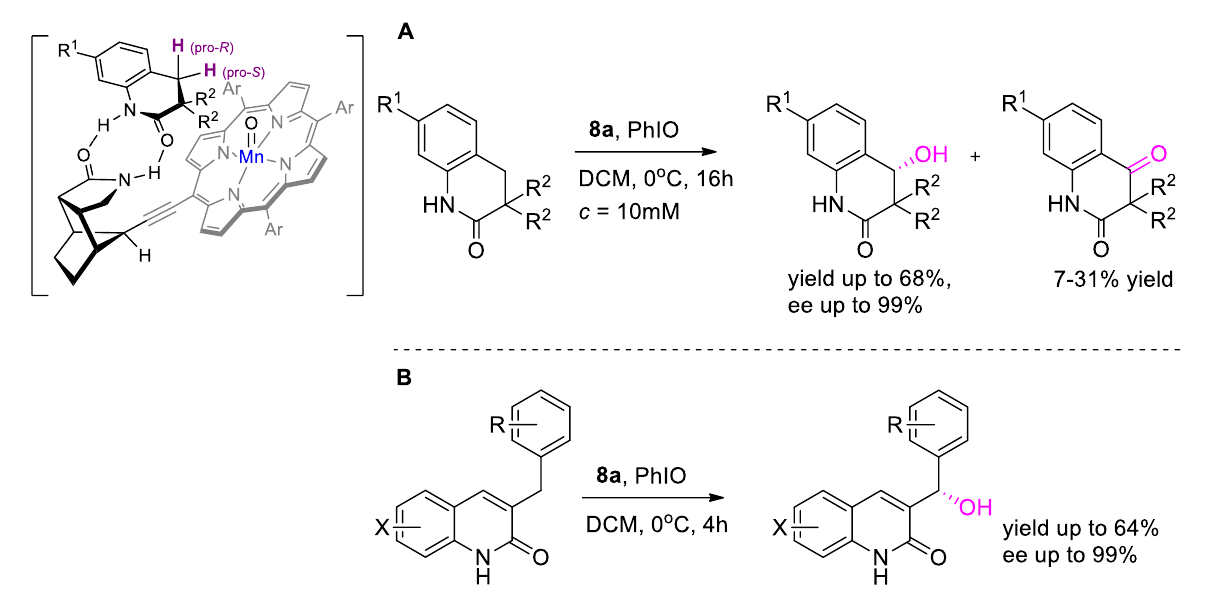
Figure 1. Structures of selected metalloporphyrin